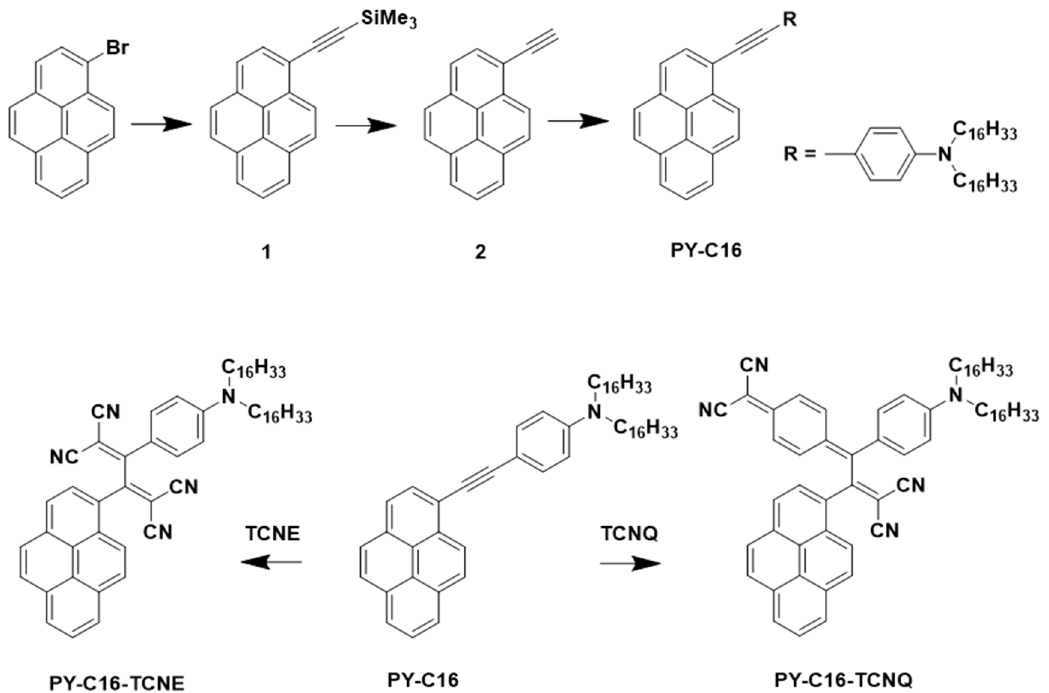
Figure 1. Synthetic route of pyrene